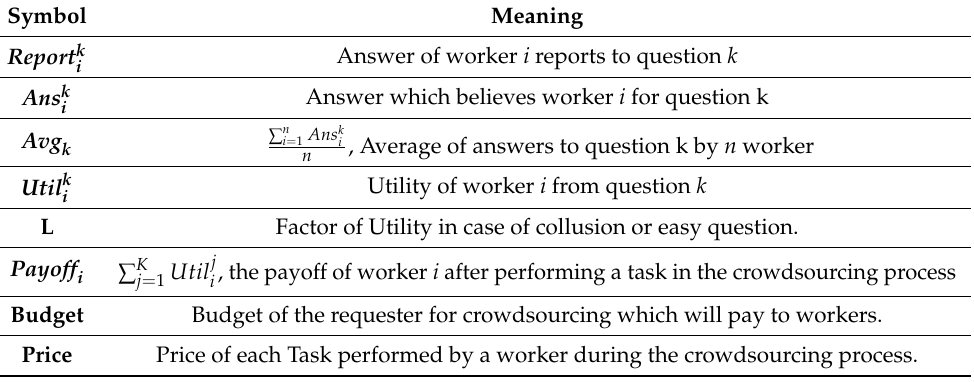
Table 2. Frequently used